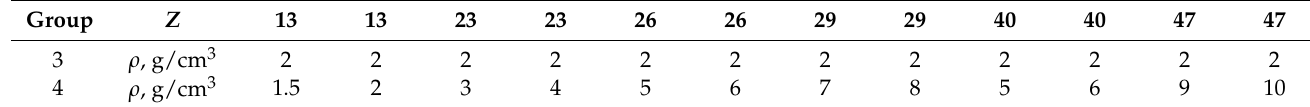
Table 1. Atomic numbers and material densities of test object fragments.